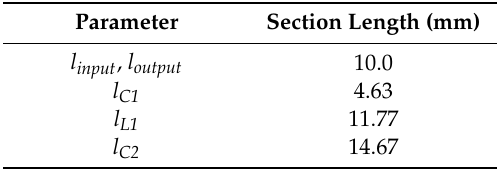
Table 2. Microstrip homogenous filter section